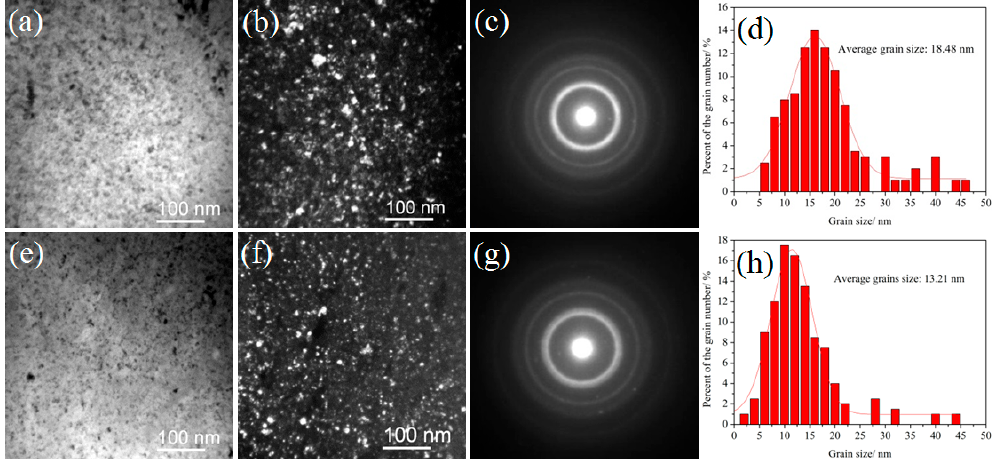
Figure 4. TEM images of the top most surface after different treatment conditions: ( a – d ) 30 min of MSP treatment; ( e – h ) 90 min of SMAT treatment.